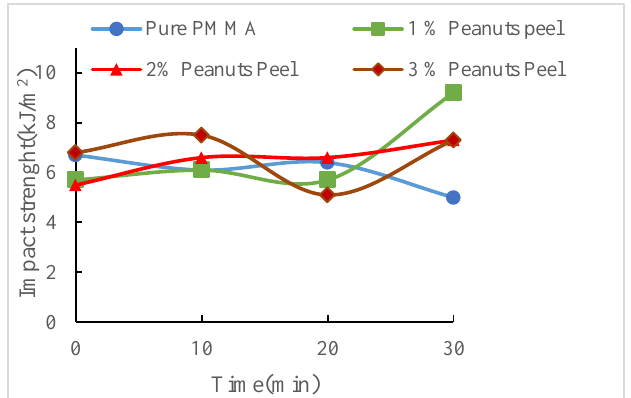
Fig.6: Influence of immersion nanocomposite PMMA + (1%, 2%, 3% of Peanuts Peel) in mineral water for (10, 20, 30 min), respectively.